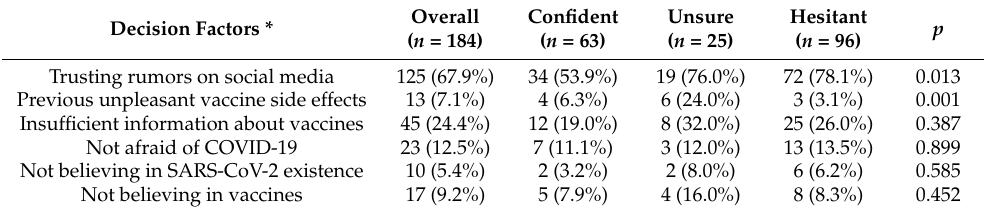
Table 3. Differences among pregnant study participants based on decision